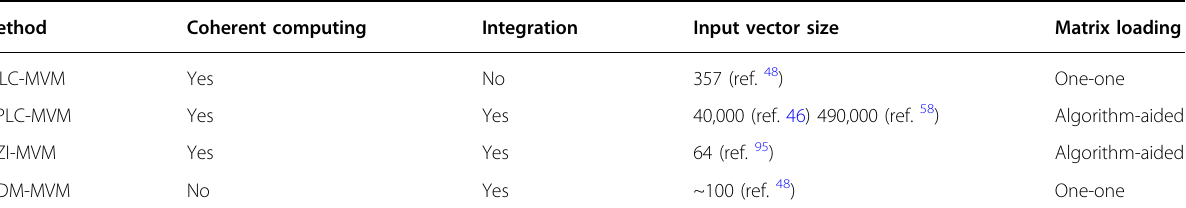
Table 1 Comparison of different photonic matrix multiplication methods